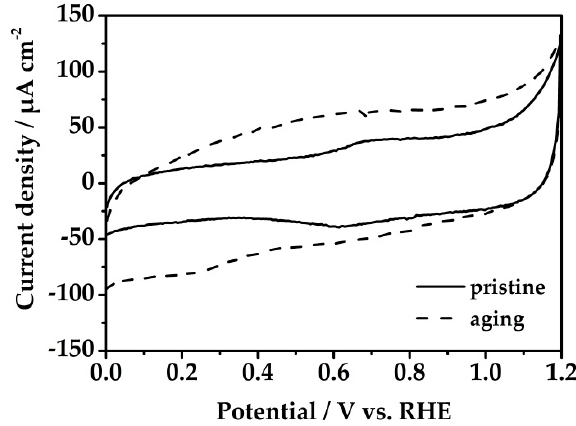
Figure 7. CVs before and after aging for 100 h at 160 °C in 15 M H 3 PO 4 with a scan rate of 20 mV s − 1 . Electrochemical measurements were done in 15 M H 3 PO 4 at room temperature.